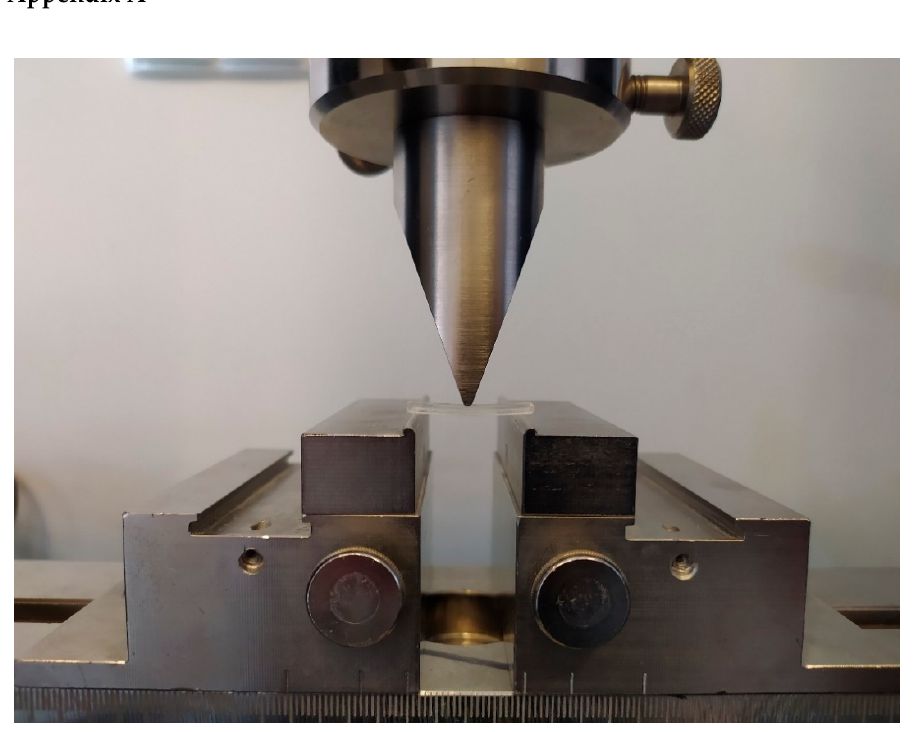
Figure A1. The three-point bending test.